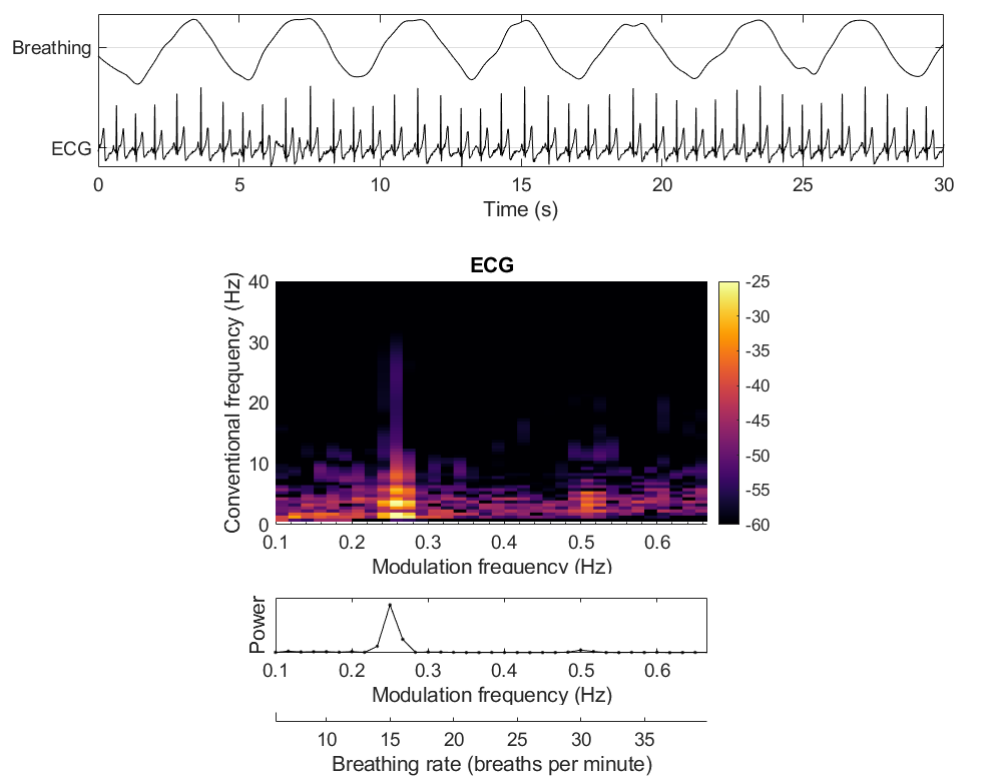
Figure 6. Measuring breathing rate from the breathing-related modulations in an ECG